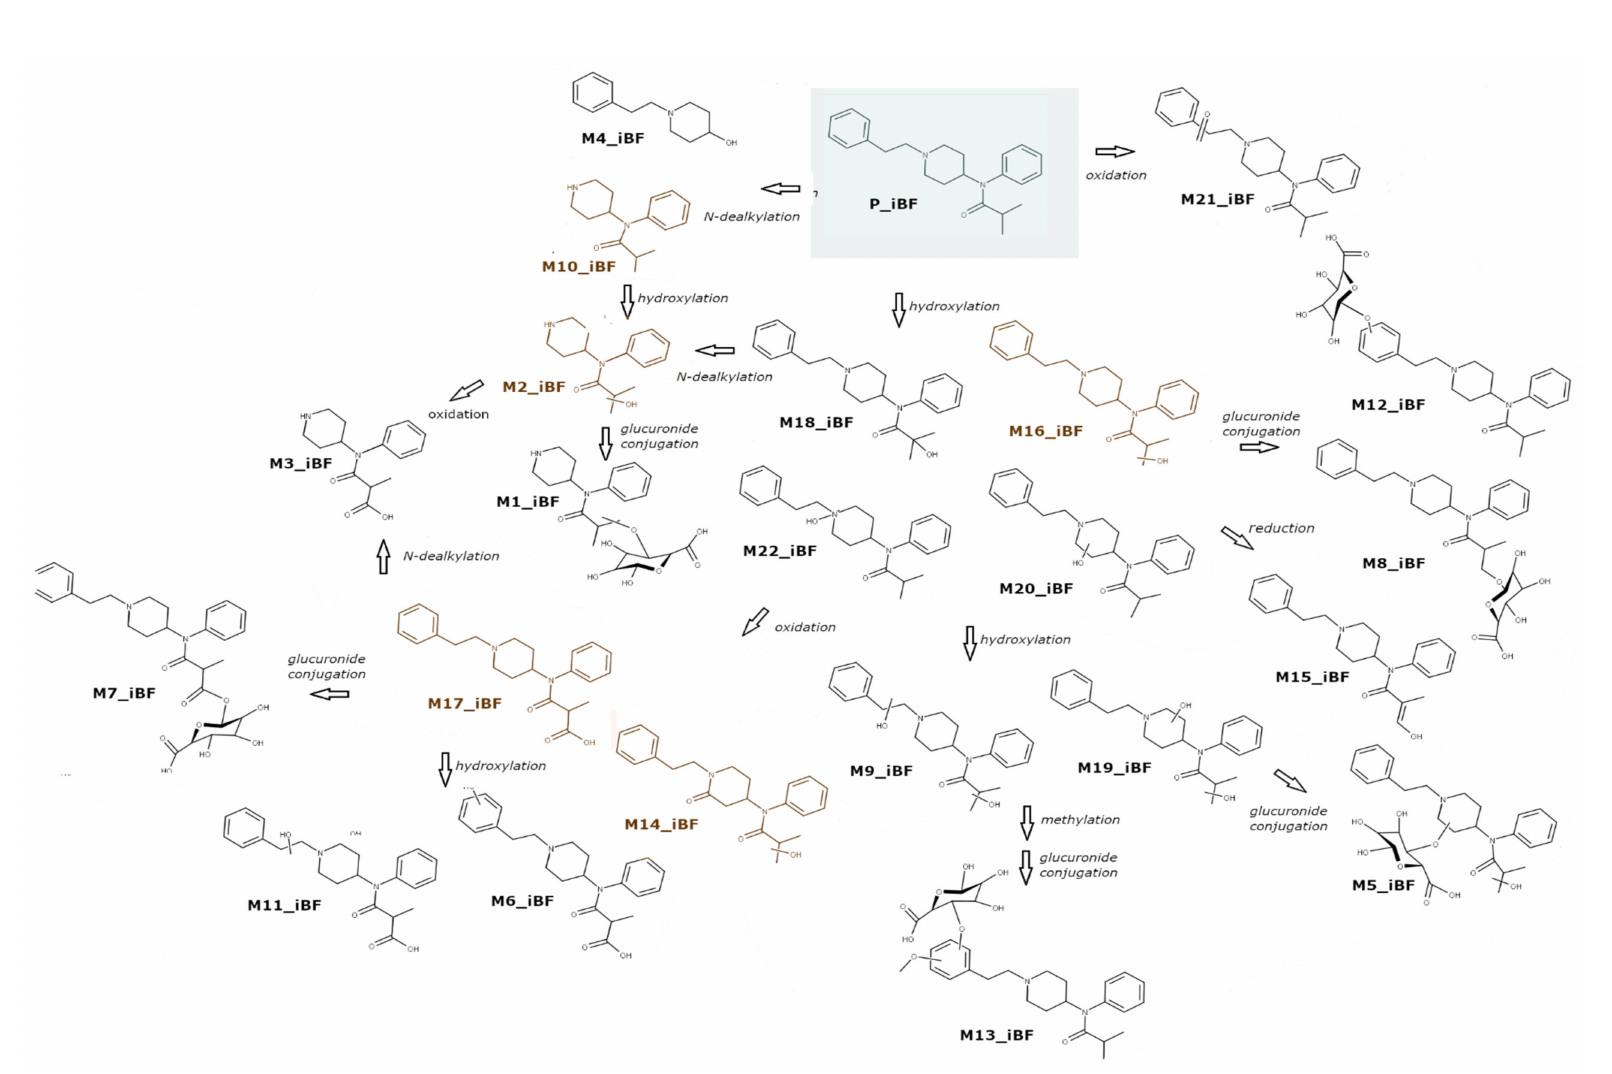
Figure 2. Proposed metabolic pathway of isobutyrylfentanyl combining both the in vitro and in vivo